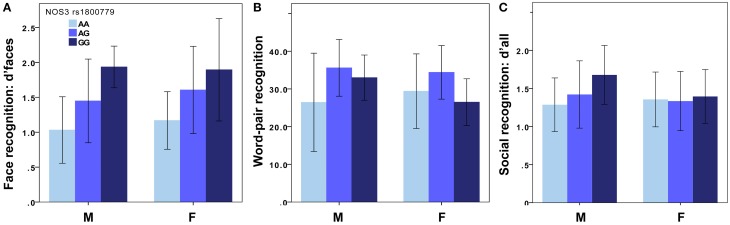
Recognition memory for NOS3 genotypes. In the exploratory study, face (A) and word recognition (B) was superior in carriers of the G-allele of the NOS3 rs1800779 (M: nAA = 9, nAG = 14, nGG = 3 for faces and nAA = 9, nAG = 15, nGG = 3 for words. F: nAA = 11, nAG = 15, nGG = 3 for faces and nAA = 10, nAG = 15, nGG = 4 for words). The results were similar for the KCNH2 polymorphism. In the validation study, social recognition memory (C) was superior in male carriers of the G-allele of the NOS3 rs1800779 (M: nAA = 126, nAG = 84, nGG = 14. F: nAA = 166, nAG = 149, nGG = 44). The results were similar for the KCNH2 polymorphism and the NOS3 rs2070744 polymorphism. The figure displays mean ± sd. M, Male; F, Female. See the Results Section for p-values.